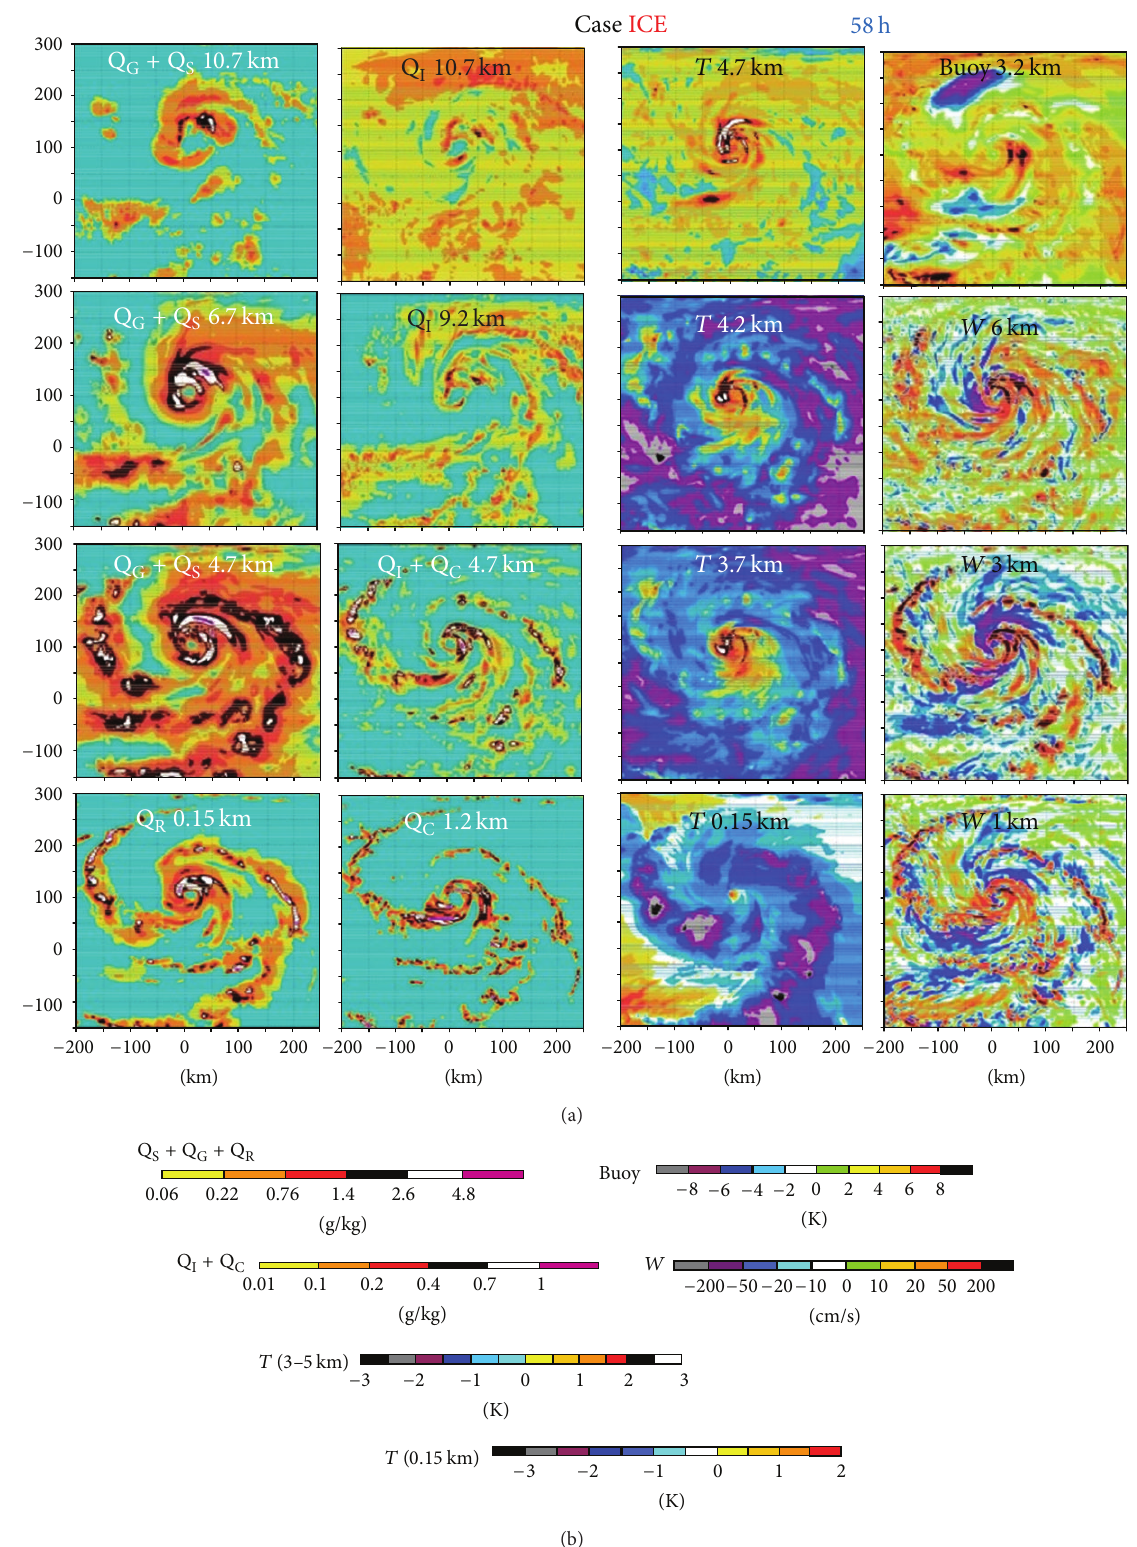
Figure 6: Mixing ratios of precipitating and nonprecipitating water substances, temperature anomaly, a measure of buoyancy of the rising air, and vertical velocity at various levels at 58h in case